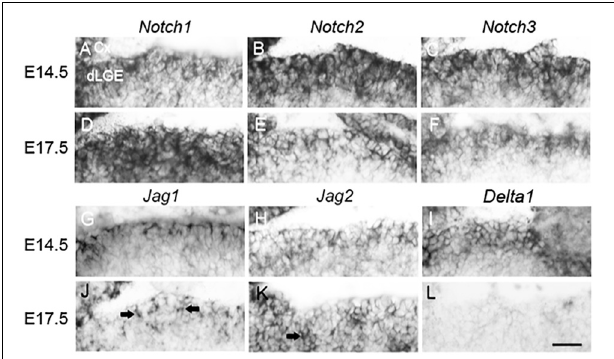
FIGURE 1 | Notch receptor and ligand expression patterns in the dorsal lateral ganglionic eminence. (A–L) RNA in situ hybridization of sagittal brain sections of Notch receptors and Notch ligands. At E14.5 and E17.5 the expression of (A,D) Notch1 , (B,E) Notch2 , and (C,F) Notch3 probes was strongly detected. At E14.5, positive signal was also detected for (G) Jag1 , (H) Jag2 , and (I) Delta1 probes. At E17.5, (J) Jag1 and (K) Jag2 probes were expressed (arrows indicate positive expression). Conversely, at E17.5, (L) Delta1 probe shows weak or no expression. Scale bar = 30 µ m. Cx, cortex; dLGE, dorsal lateral ganglionic eminence.